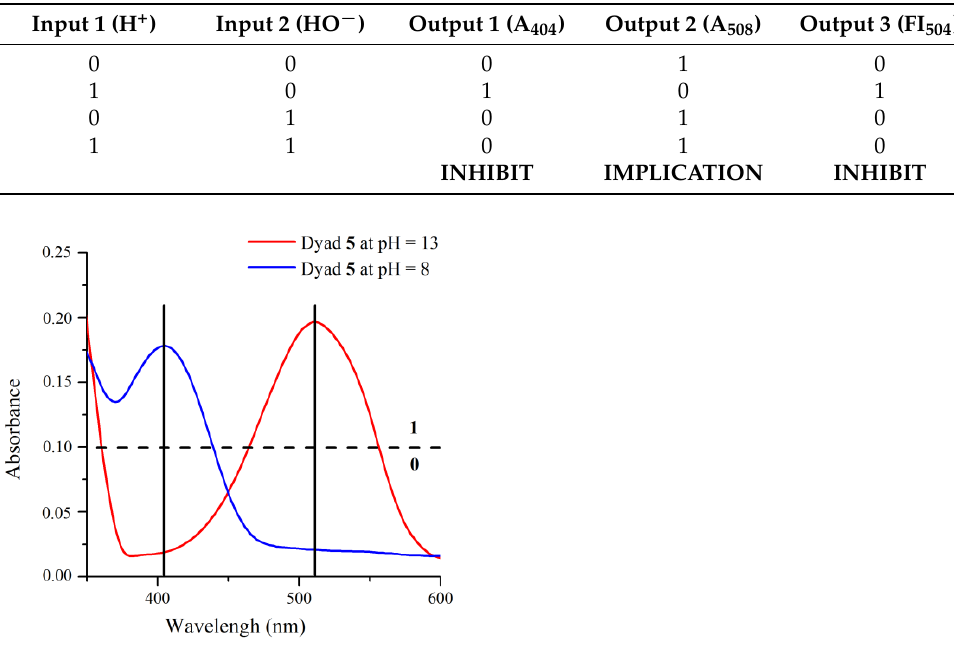
Figure 7. The changes in the absorbance of Dyad 5 at 404 nm (Output 1) and at 508 nm (Output 2) with two chemical inputs (Table 2).